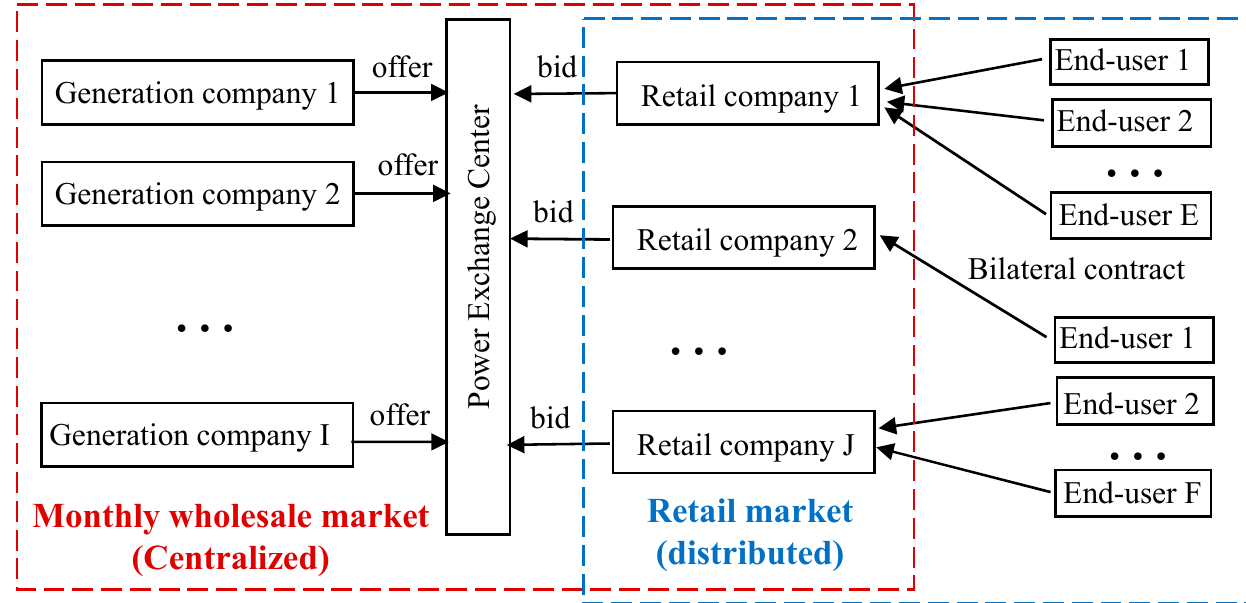
Figure 1. Structure of the electricity market.